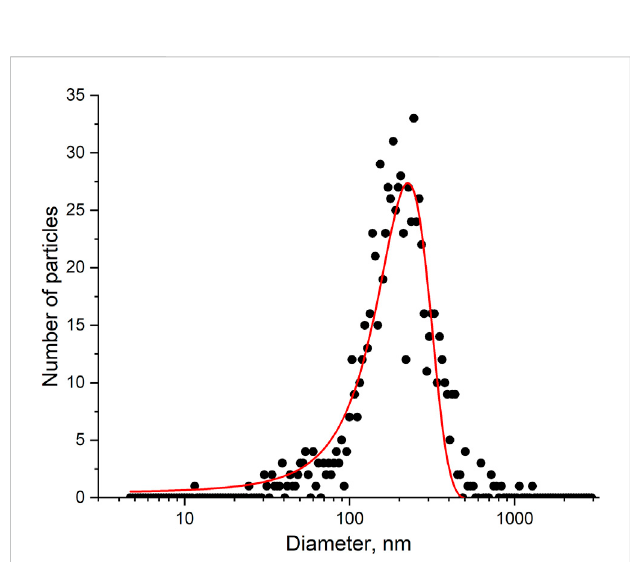
A nanoparticle trackinganalysisofthein fl uenzaAvirus sample. The experimental size distribution of the nanoparticles and its